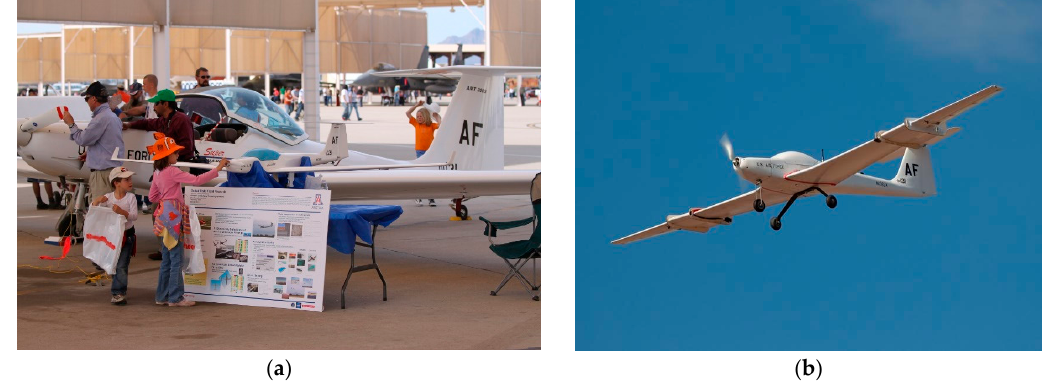
Figure 1. ( a ) Full-size and 1:5 scale AMT 200S. ( b ) 1:5 model in flight.